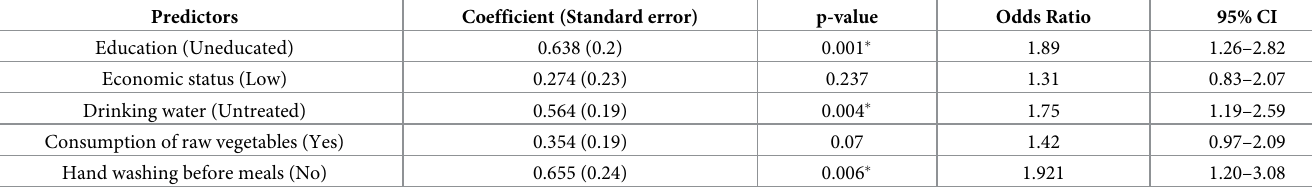
Table 3. Logistic regression model showing factors associated with the presence of Entamoeba